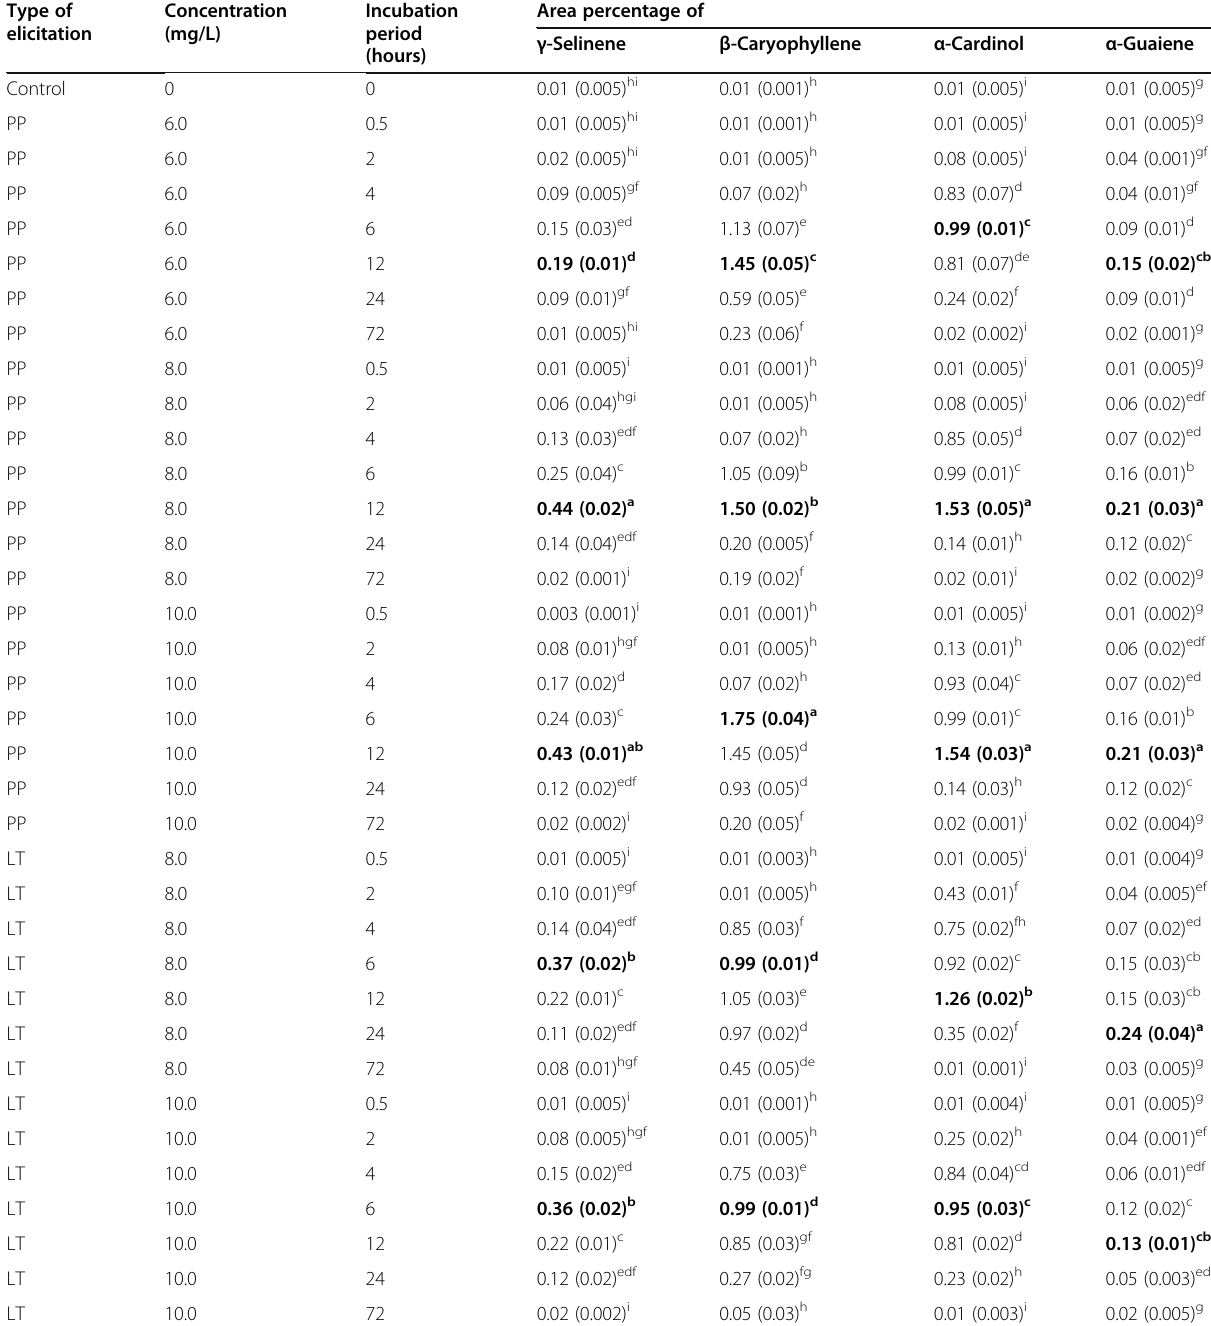
Table 4 Effect of biological elicitors on Gyrinops walla cell suspension Type of